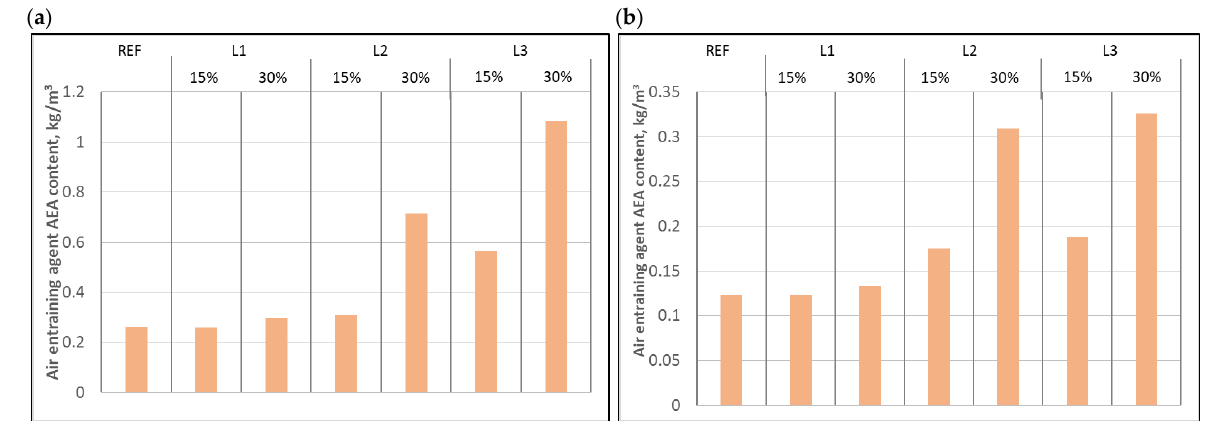
Figure 2. Amount of air-entraining admixture for ( a ) vibrated and ( b ) self-compacting concrete to obtain 6% ± 1% of air content in the concrete mix.